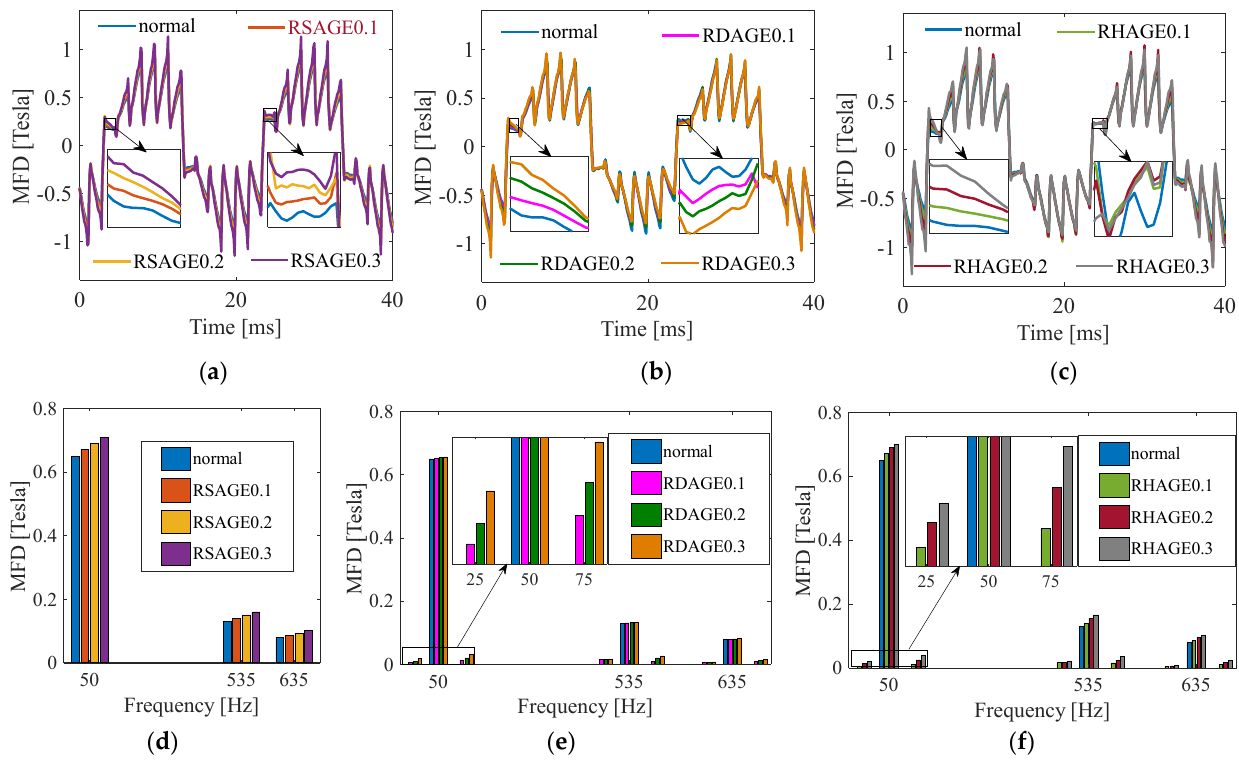
Figure 5. The MFD at minimum air gap under normal and RAGE conditions: ( a ) the MFD time domain in RSAGE; ( b ) the MFD time domain in RDAGE; ( c ) the MFD time domain in RHAGE; ( d ) the frequency domain in RSAGE; ( e ) the frequency domain in RDAGE; and ( f ) the frequency domain in RHAGE.